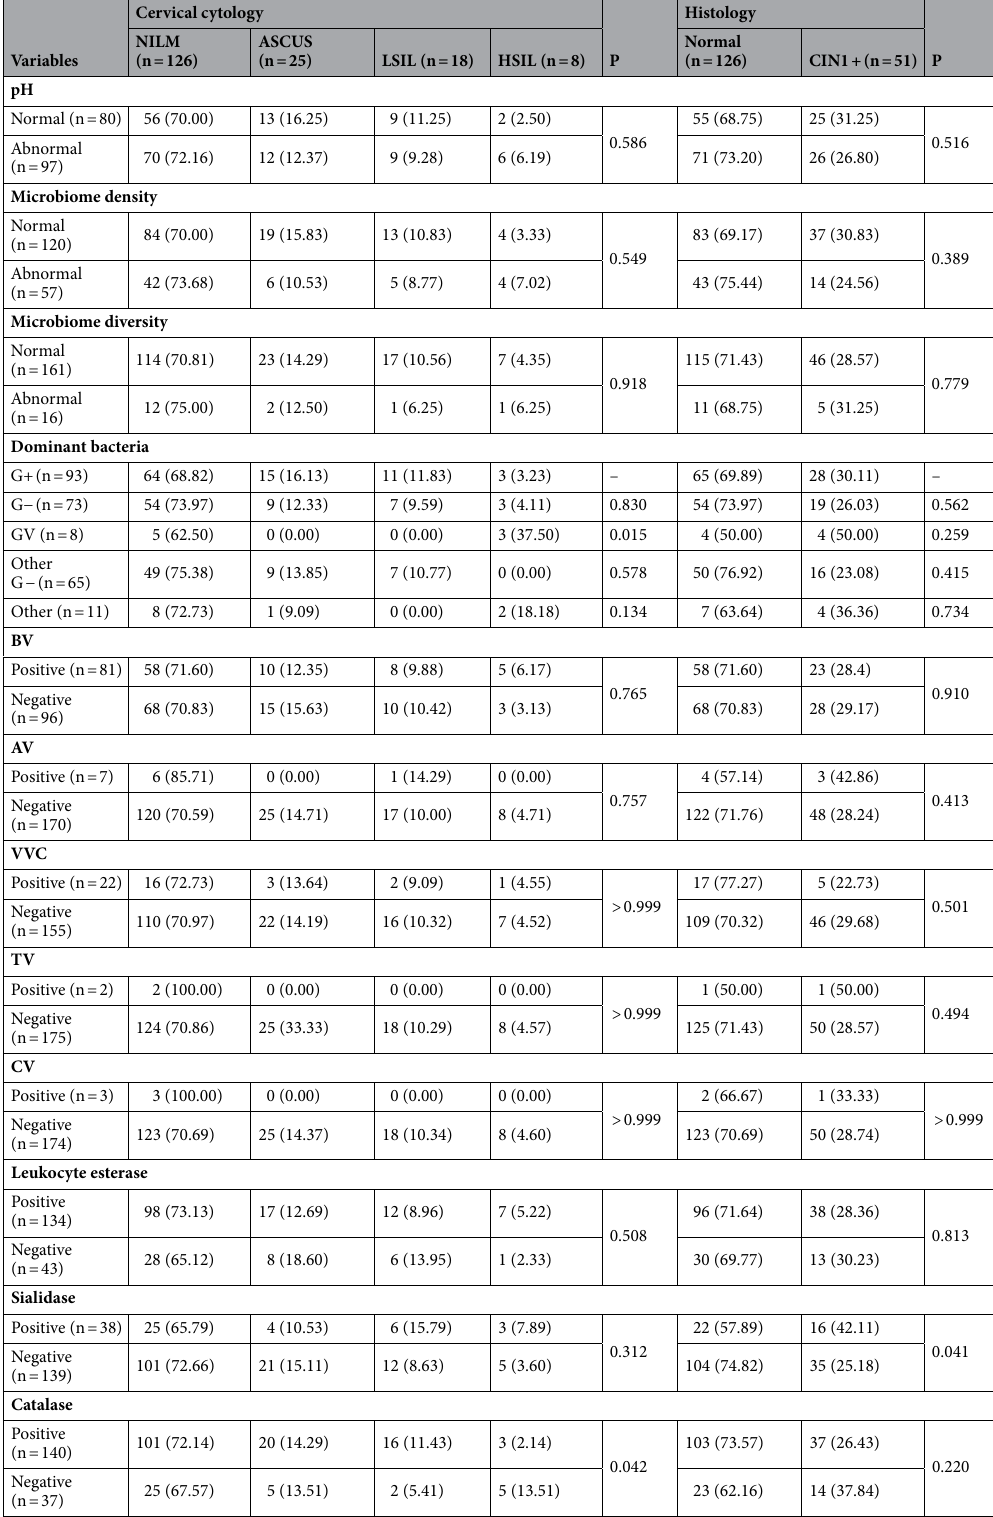
Table 4. The changes of micro-environment factors between different cervical lesions. HSIL includes HSIL, AGC, ASC-H. The above results all use Fisher’s exact test method. G + Gram-positive bacteria, G−